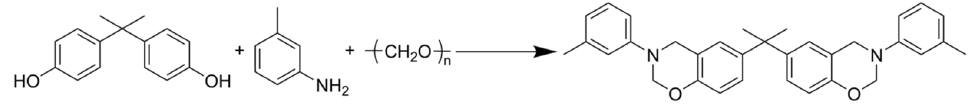
Figure 2. Synthetic scheme of benzoxazine monomer BA-mt.